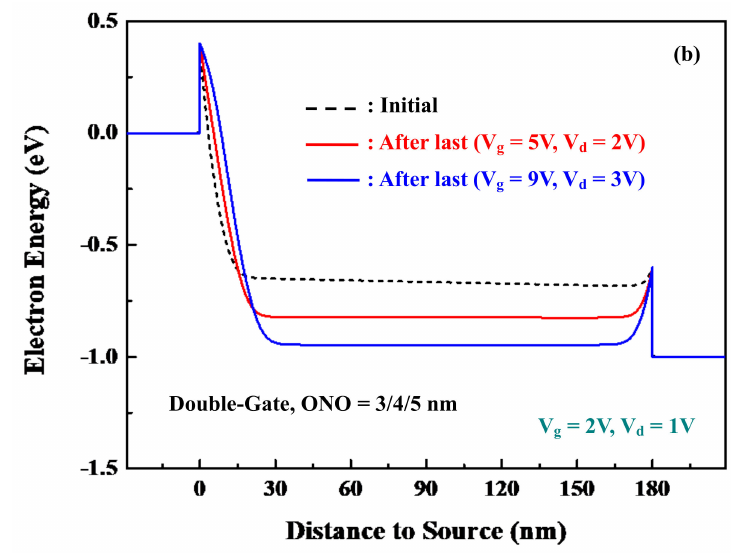
Figure 16. ( a ) Reading currents of two programmed double-gate Schottky barrier cells after each programming interval (V read = 1 V); ( b ) associated conduction band diagrams of two charge-trapping cells along the channel surface at the initial and after last programming